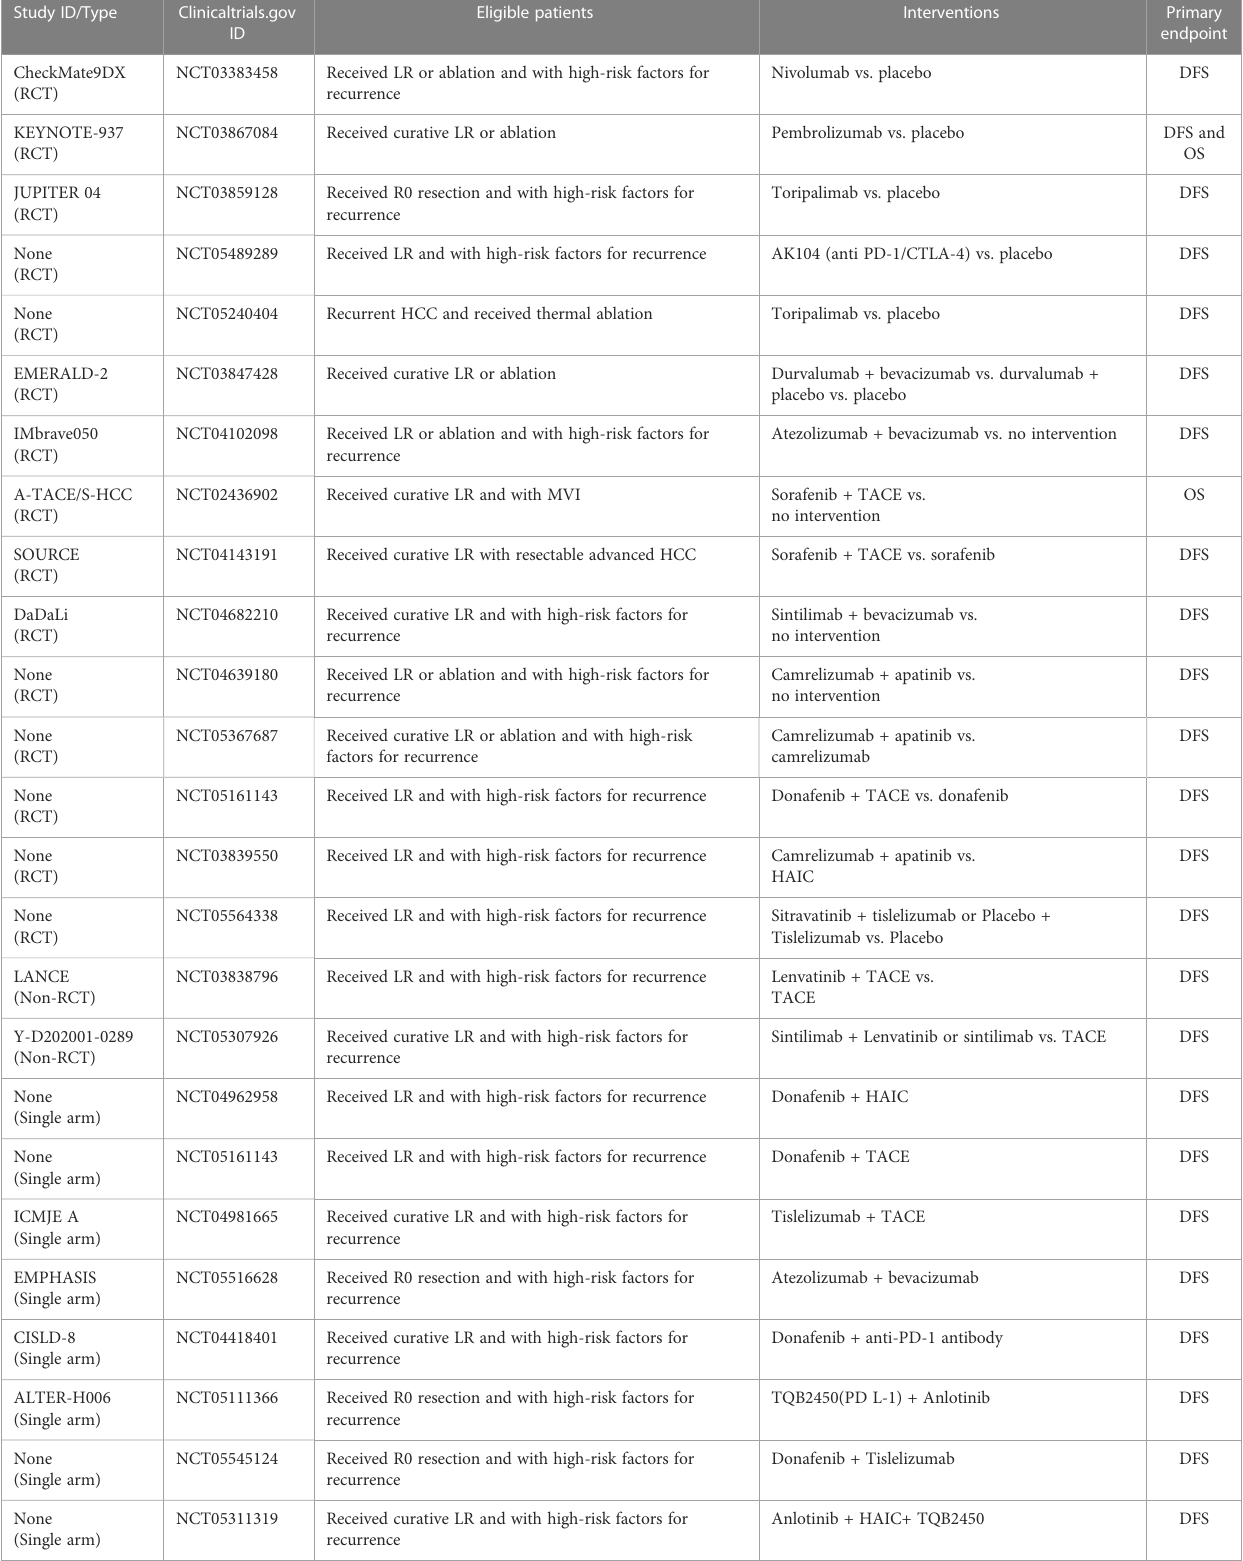
TABLE 1 Summary of important ongoing trials on PD-1, and various combination therapies as adjuvant therapy following LR or